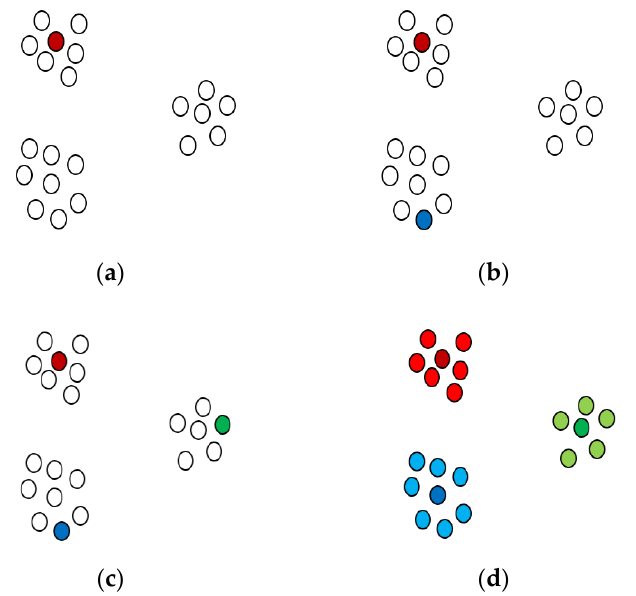
Figure 2. Clustering process using the k -means++ algorithm. ( a ) First centroid selection. ( b ) Second centroid selection. ( c ) Third centroid selection. ( d ) Result of clustering.